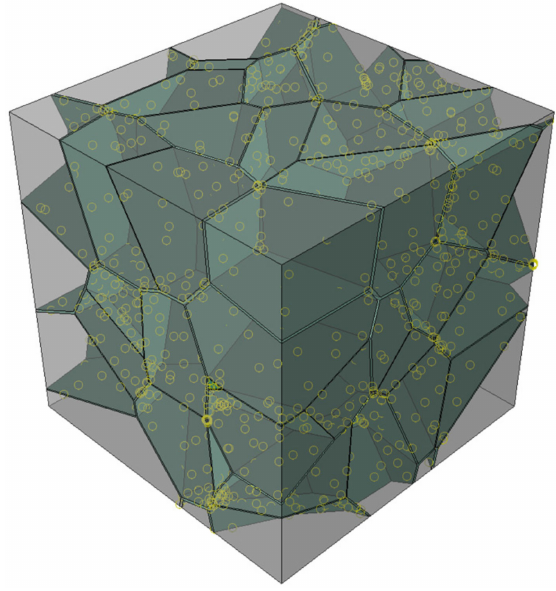
Figure 6. Assembling parts through cohesive